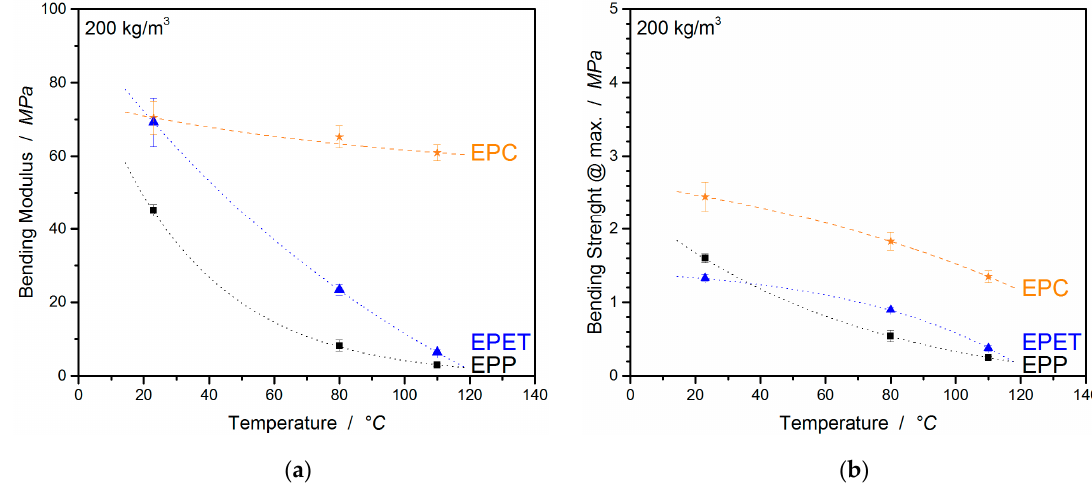
Figure 10. Three-point-bending curves for EPC, EPP, and EPET at 25 ( a ), 80 ( b ), and 110 °C ( c ). At room temperature, EPC has the highest flexural modulus of 70.5 MPa followed by EPET with 69.2 MPa. EPP, on the other hand, performs comparatively poorly at a density of 200 kg/m 3 with 45.3 for EPP drops by 81.5%, and for EPET, by 65.4%. EPC, on the other hand, has a continuous service temperature of up to ~130 °C and only exhibits a modulus drop of 7.4% (65.3 MPa) at a temperature same trend continues at 110 °C. EPC has a 20 × higher bending modulus than EPP and 10 × higher